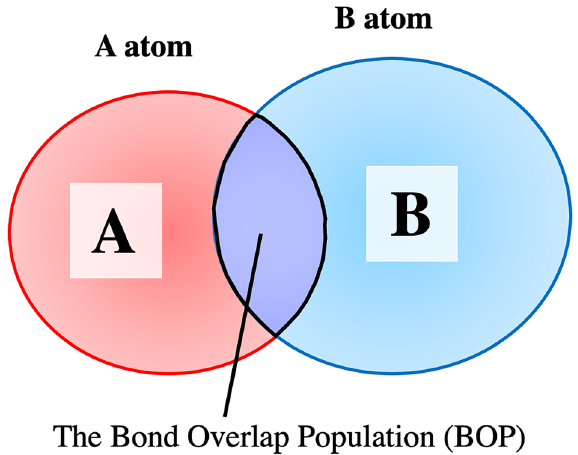
Figure 13. The image of the bond overlap population (BOP) is shown. The color spread is replaced as the wave function in each